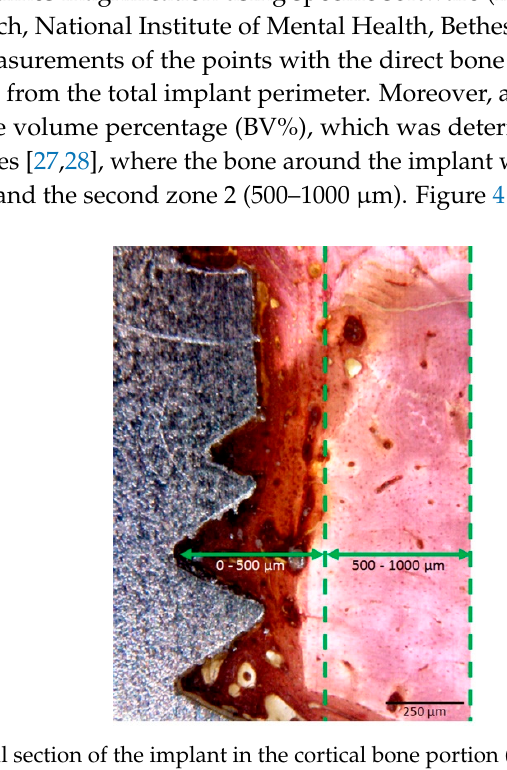
Figure 4. Histological section of the implant in the cortical bone portion (magnification 40×) showing 2 zones determined for histomorphometric analysis, which the first zone (0–500 µm) and the second zone (500–1000